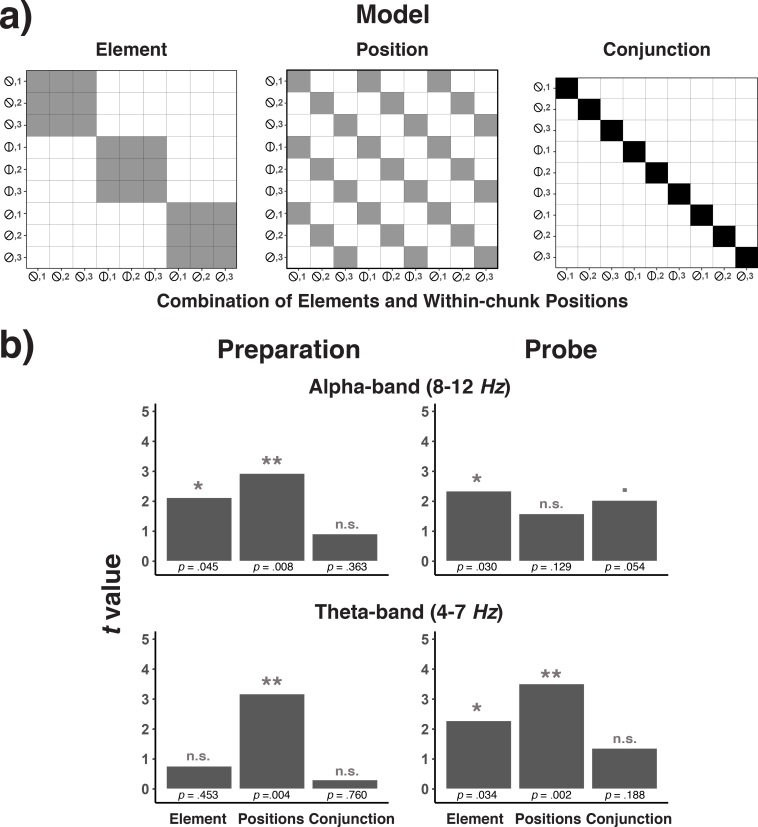
Model confusion matrices for testing element, position, and element-position conjunctions (a) and the results of testing each of these matrices across frequency bands and trial phases (b).(a) Model matrices that describe the similarity structure by the variation in elements, positions, and conjunctions of elements and positions (see the text for details). Black cells in the model matrices represent a theoretically expected correct classification probability of p = 1.0, gray cells of p = 0.33, and white cells of p = 0. (b) T-values associated with regression coefficients for each of the three model predictors are presented separately for the preparation and the probe period and for the theta- and alpha-band.